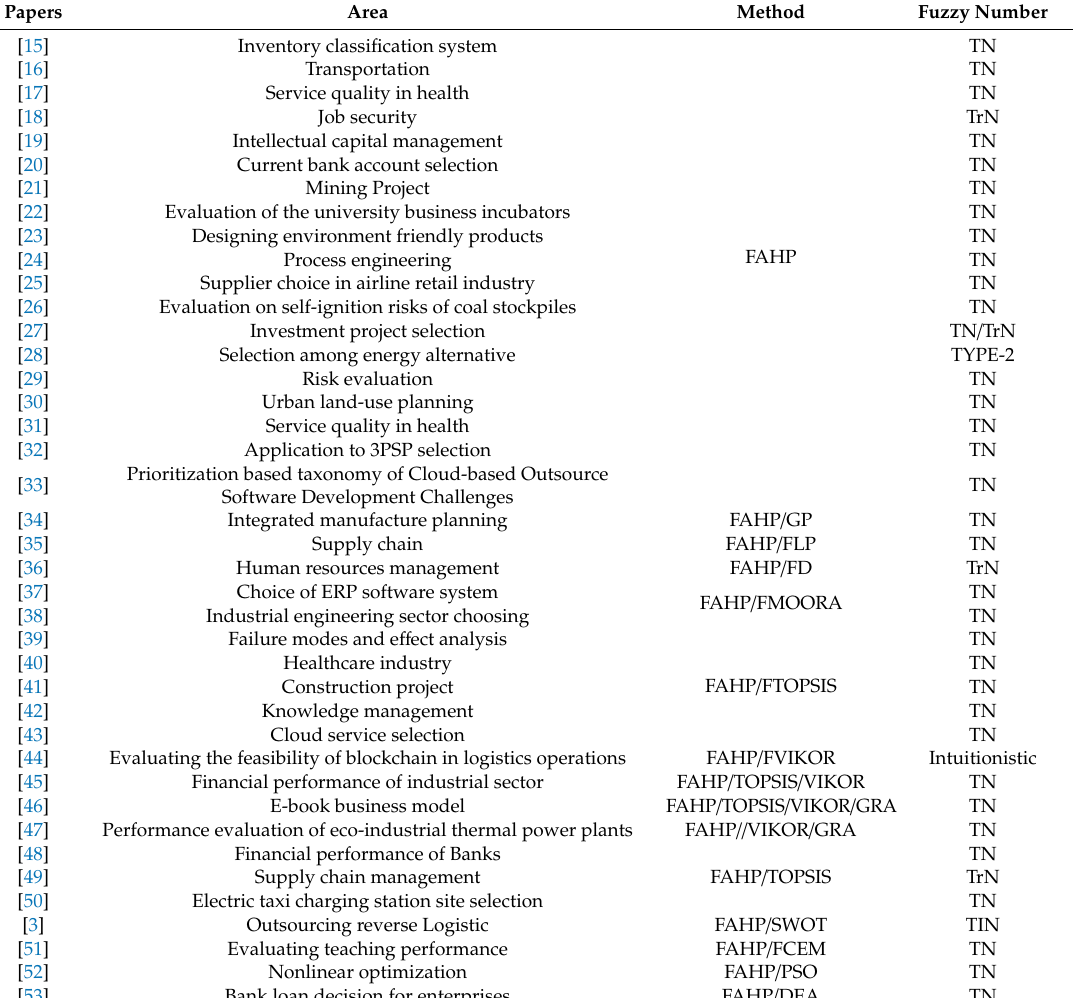
Table 1. Fuzzy AHP application areas, methods and types of fuzzy